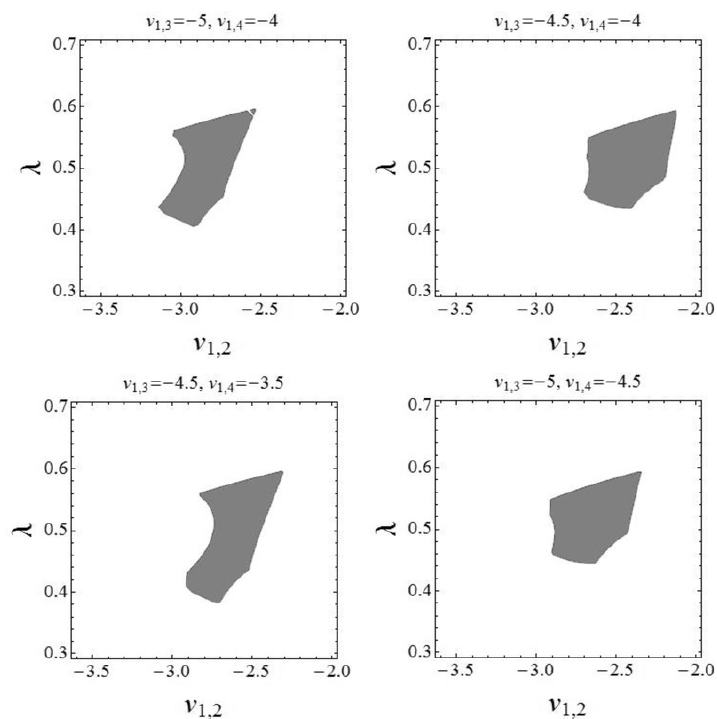
Figure 3. A - and L -stable methods of stage order q = 6 and order p =